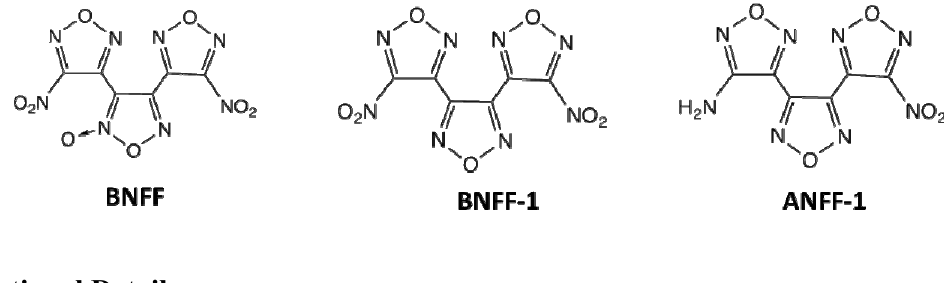
Figure 1. Structures of 3,4-bis(4-nitro-1,2,5-oxadiazol-3-yl)-1,2,5-oxadiazole-N-oxide (BNFF), 3,4-bis(4-nitro-1,2,5-oxadiazol-3-yl)-1,2,5-oxadiazole (BNFF-1) and 3-(4-amino- 1,2,5-oxadiazol-3-yl)-4-(4-nitro-1,2,5-oxadiazol-3-yl)-1,2,5-oxadiazole